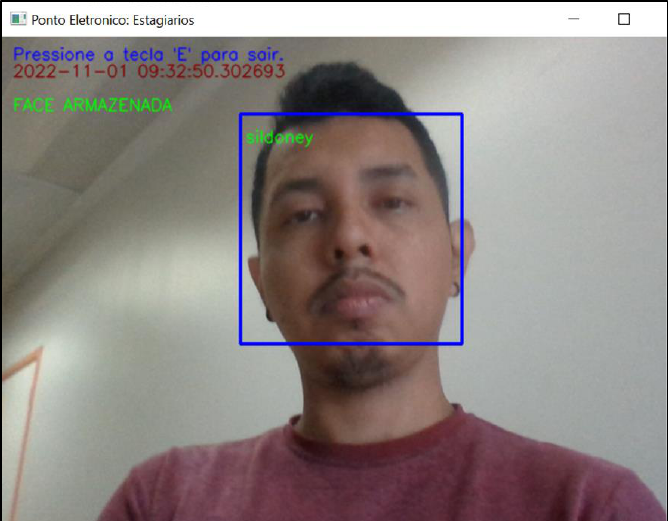
Figure 32: User 1 with correct name.